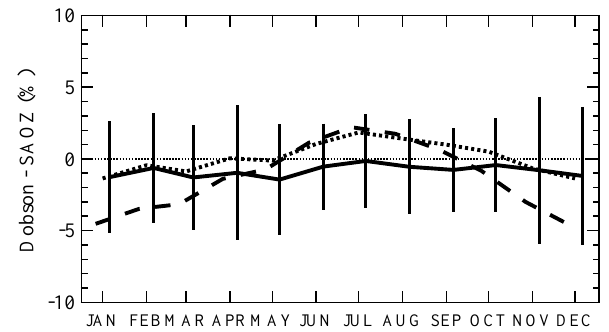
Fig. 7. Seasonal variation of the Dobson-SAOZ relative difference at OHP (dashed line: SAOZ V1, dotted line: SAOZ V2, solid line: Dobson corrected for temperature).